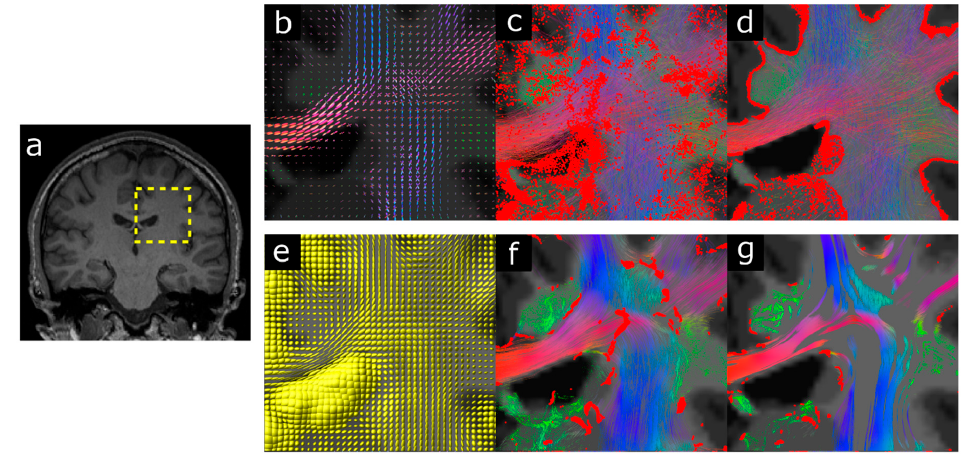
Figure 5. Demonstration of the e ff ects of incorporating anatomical priors during fibre-tracking. ( a ) Coronal T1-weighted anatomical image highlighting by the yellow dotted lines the zoomed region. ( b ) Fibre Orientation Distributions on the zoomed region, overlaid on the segmented anatomical image. ( c ) Streamlines computed using probabilistic tracking without incorporating anatomical priors. ( d ) Corresponding streamlines from probabilistic tracking when the Anatomically Constrained Tractography (ACT) framework is considered. ( e ) Diffusion tensors on zoomed region. ( f ) DTI-based deterministic fibre-tracking results without incorporating anatomical priors. ( g ) Corresponding DTI-based streamline results when the ACT framework is considered. Streamline terminations are indicated by the red dots. For all cases, only streamlines within a 0.9 coronal slice are shown. Figure modified from a figure previously published in [47], with permission of Elsevier Inc,